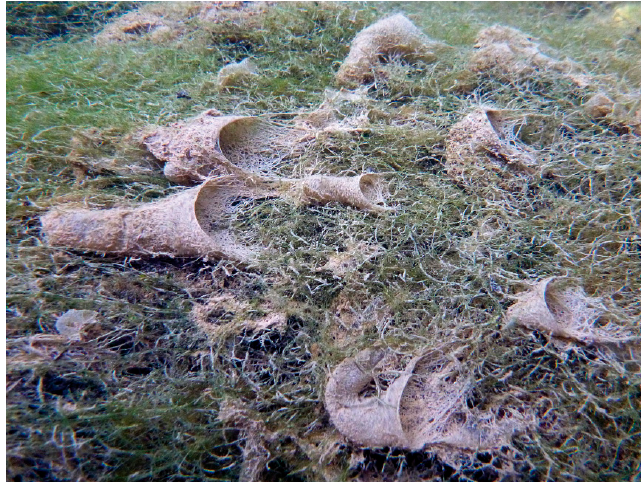
Figure 5. Capture nets of Neureclipsis sp. (Polycentropodidae). © W. Graf. Insects 2019 , 10 , 125